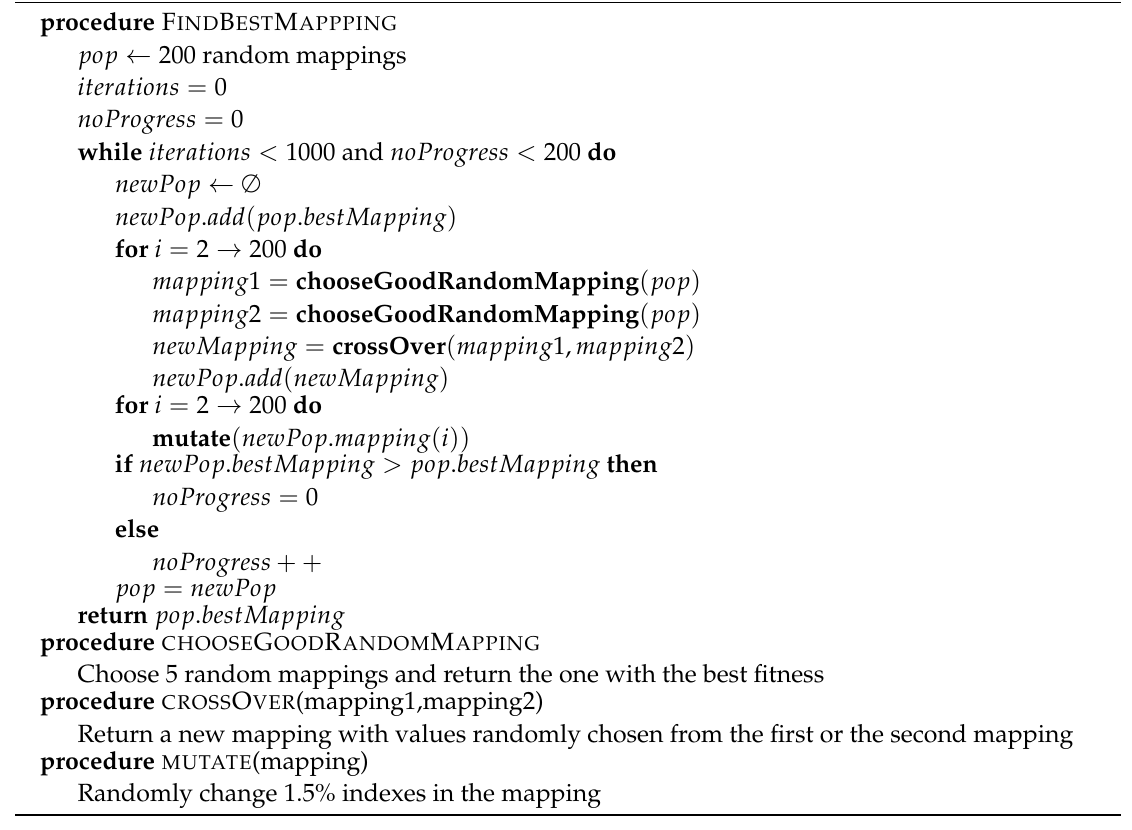
Algorithm 1 Heuristic genetic algorithm searching for the best